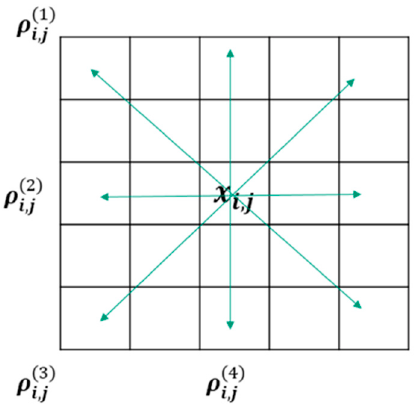
Figure 3. Filter window and its main four directions.